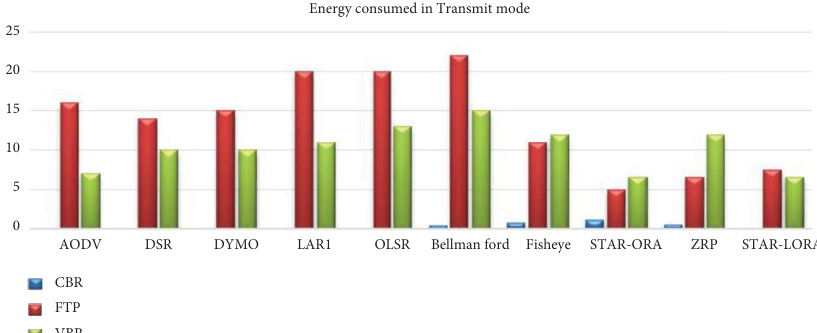
Figure 12: Transmit mode energy consumption of all routing protocols for 60 nodes.